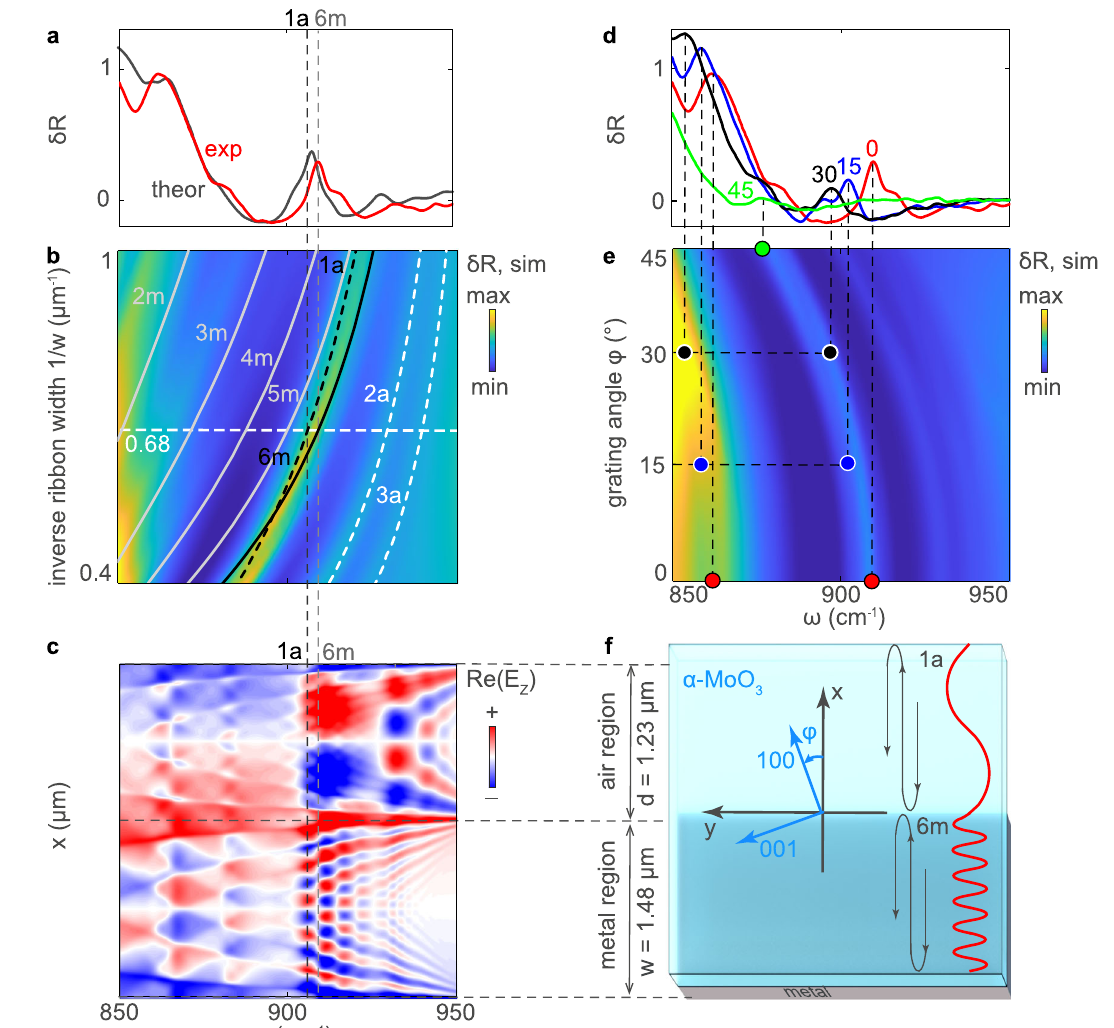
Fig. 2 Analysis of the PhP resonances and their twist tuning. a Measured and simulated relative re fl ection spectra, δ R (solid red and gray curves, respectively), for a ribbon width w ¼ 1480 nm, a separation distance d ¼ 1230 nm and a twist angle φ ¼ 0 (cid:4) . The fl ake thickness is 110 nm. b Simulated δ R as a function of frequency, ω , and inverse ribbon width, 1 = w , for a fi xed ratio w = d . The FPR conditions for PhP in α - MoO 3 above the air and metal regions are traced by the white solid and dashed lines, respectively. c Simulated fi eld distributions of the M0 and M1 PhP modes in the α -MoO 3 /air and α -MoO 3 /metal regions, respectively, as a function of ω and the x coordinate (short axis of the ribbons). d Measured δ R spectra for twist angles of the same α -MoO 3 slab φ ¼ 0 ; 15 ; 30 and 45° (red, blue, black and green, respectively). e Simulated relative re fl ection as a function of ω and φ . f Top view of one lattice unit